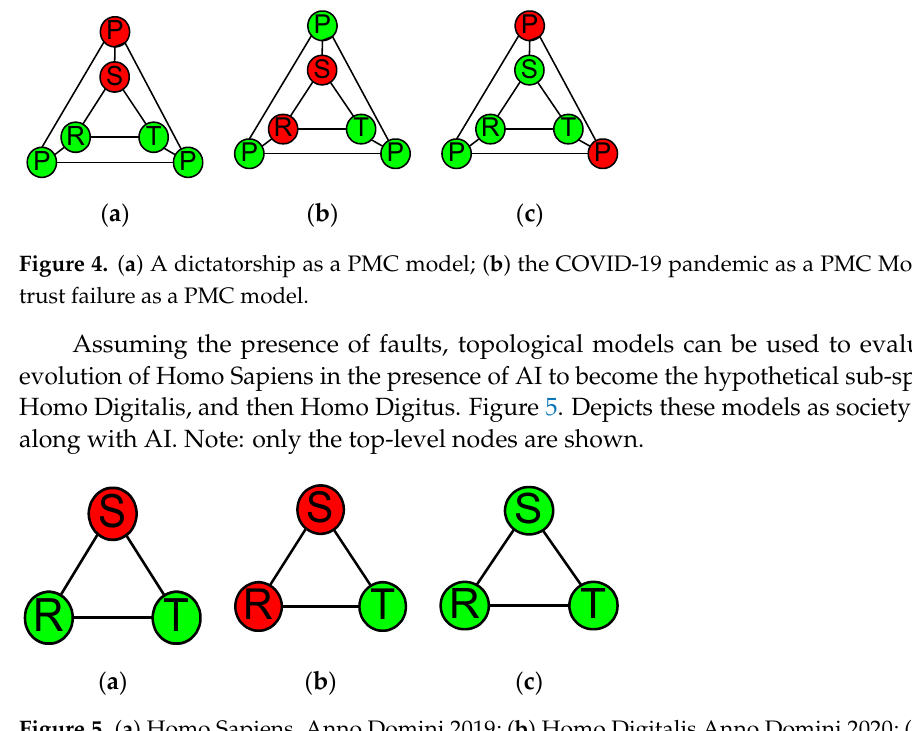
Figure 5. ( a ) Homo Sapiens, Anno Domini 2019; ( b ) Homo Digitalis Anno Domini 2020; ( c ) Homo Digitus Anno Domini 2021.